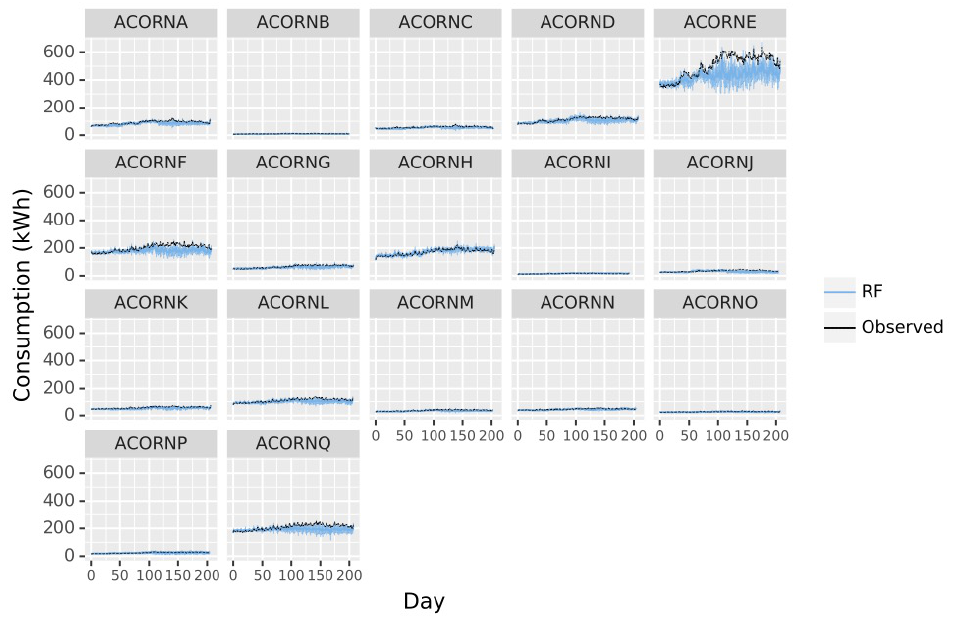
Figure 6. RF mean predictions by day of the week (average values of 24 h observations) for each ACORN group across the latest 270 days of data. Error bars represent predictions square deviation considering average 24 h errors.